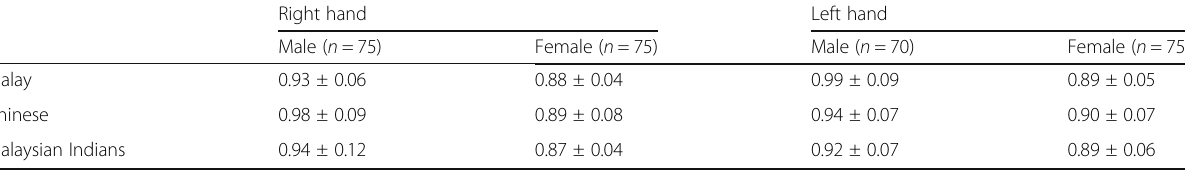
Table 2 Mean ± SD of 2D:4D digit ratio among the males and females of Malaysian ethnicity Right